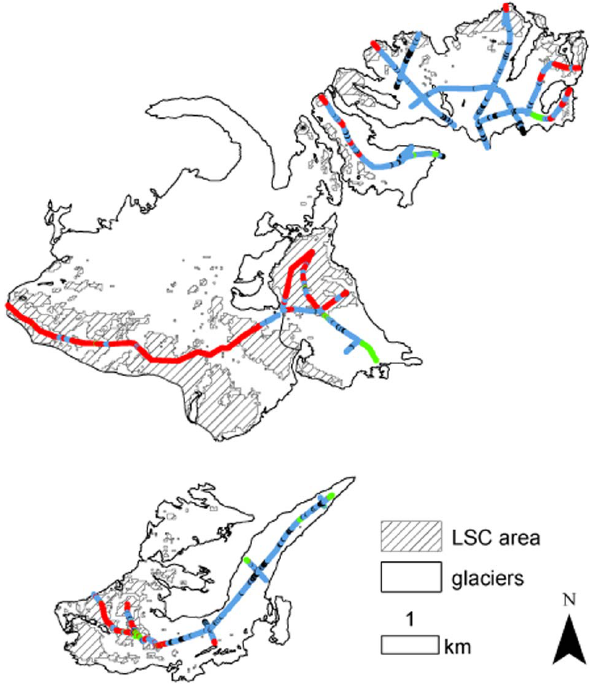
Fig. 13. Results of similarity between 1z ALS and h GPR applying a Mann–Whitney–Wilcoxon test (level of significance p =0.05) and the comparison of 1h abs (Eq. 11) to uncertainties of the two meth- ods: ALS and GPR (Eq. 12) are given. Each midpoint of a win- dow including n = 300 samples is coloured indicating not signifi- cant 1h abs (black), significant 1h abs (blue), significant and nega- tive 1h abs larger than uncertainty (red) and significant and positive 1h abs larger than uncertainty (green). The outlines of the inves- tigated glaciers (black) and the snow cover derived from Landsat image of 31 August 2009 (LSC, striped) are